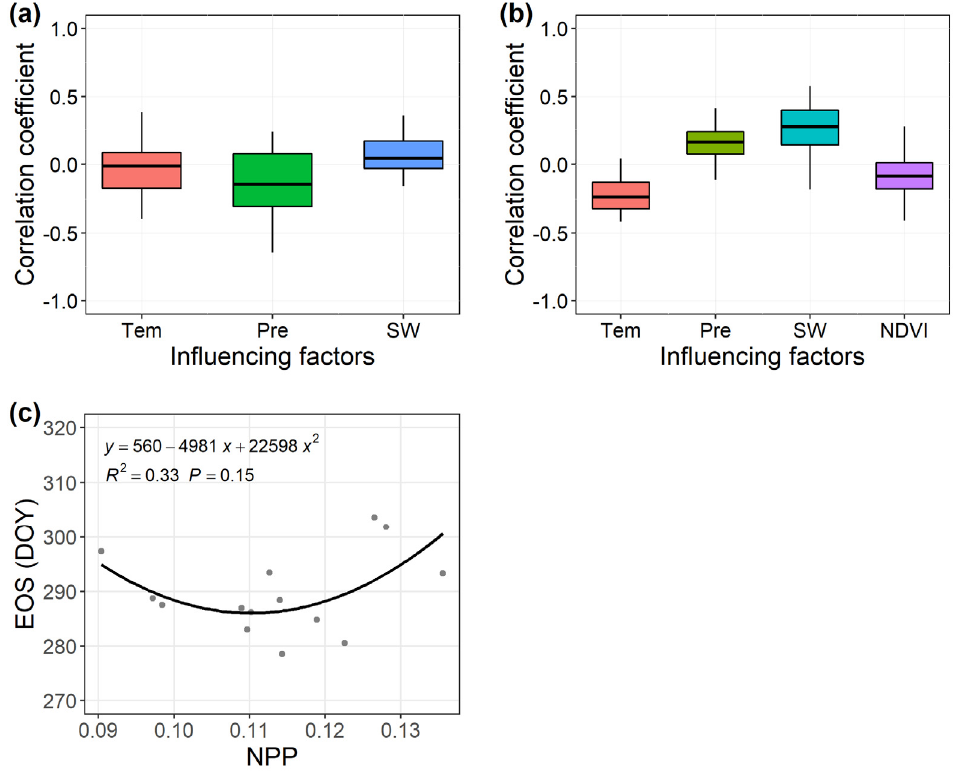
Figure 6. Correlation coefficients between ( a ) SOS and spring average temperature (‘Tem’), total precipitation (‘Pre’), and mean shortwave radiation (‘SW’), and between ( b ) EOS and autumn average temperature, total precipitation, mean shortwave radiation, and NDVI. ( c ) Correlation between EOS and autumn total NPP.